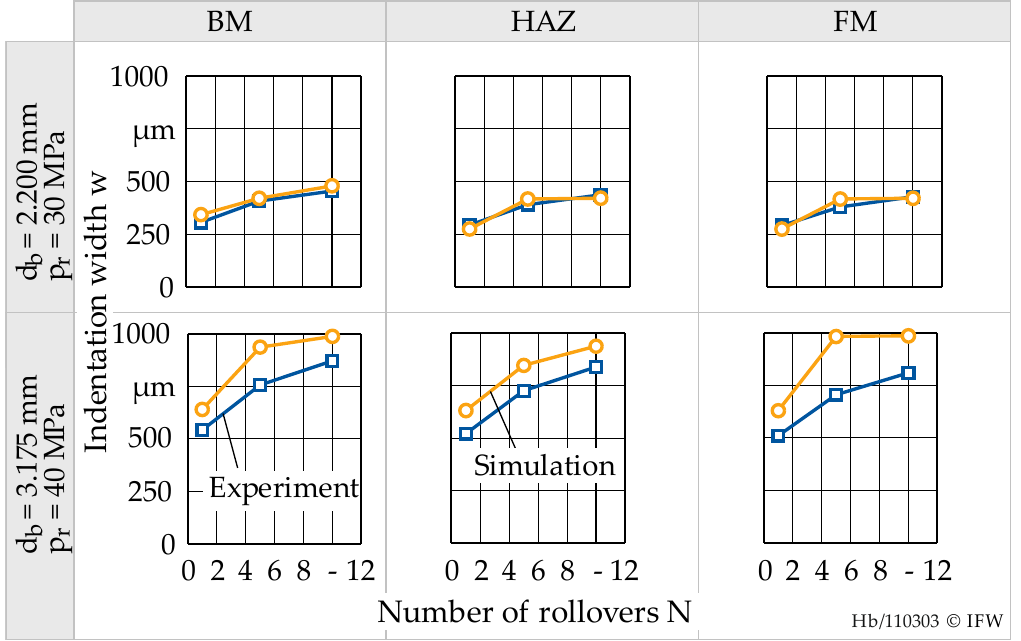
Figure 8. Comparison of experimentally and numerically determined indentation widths for two different parameter combinations .